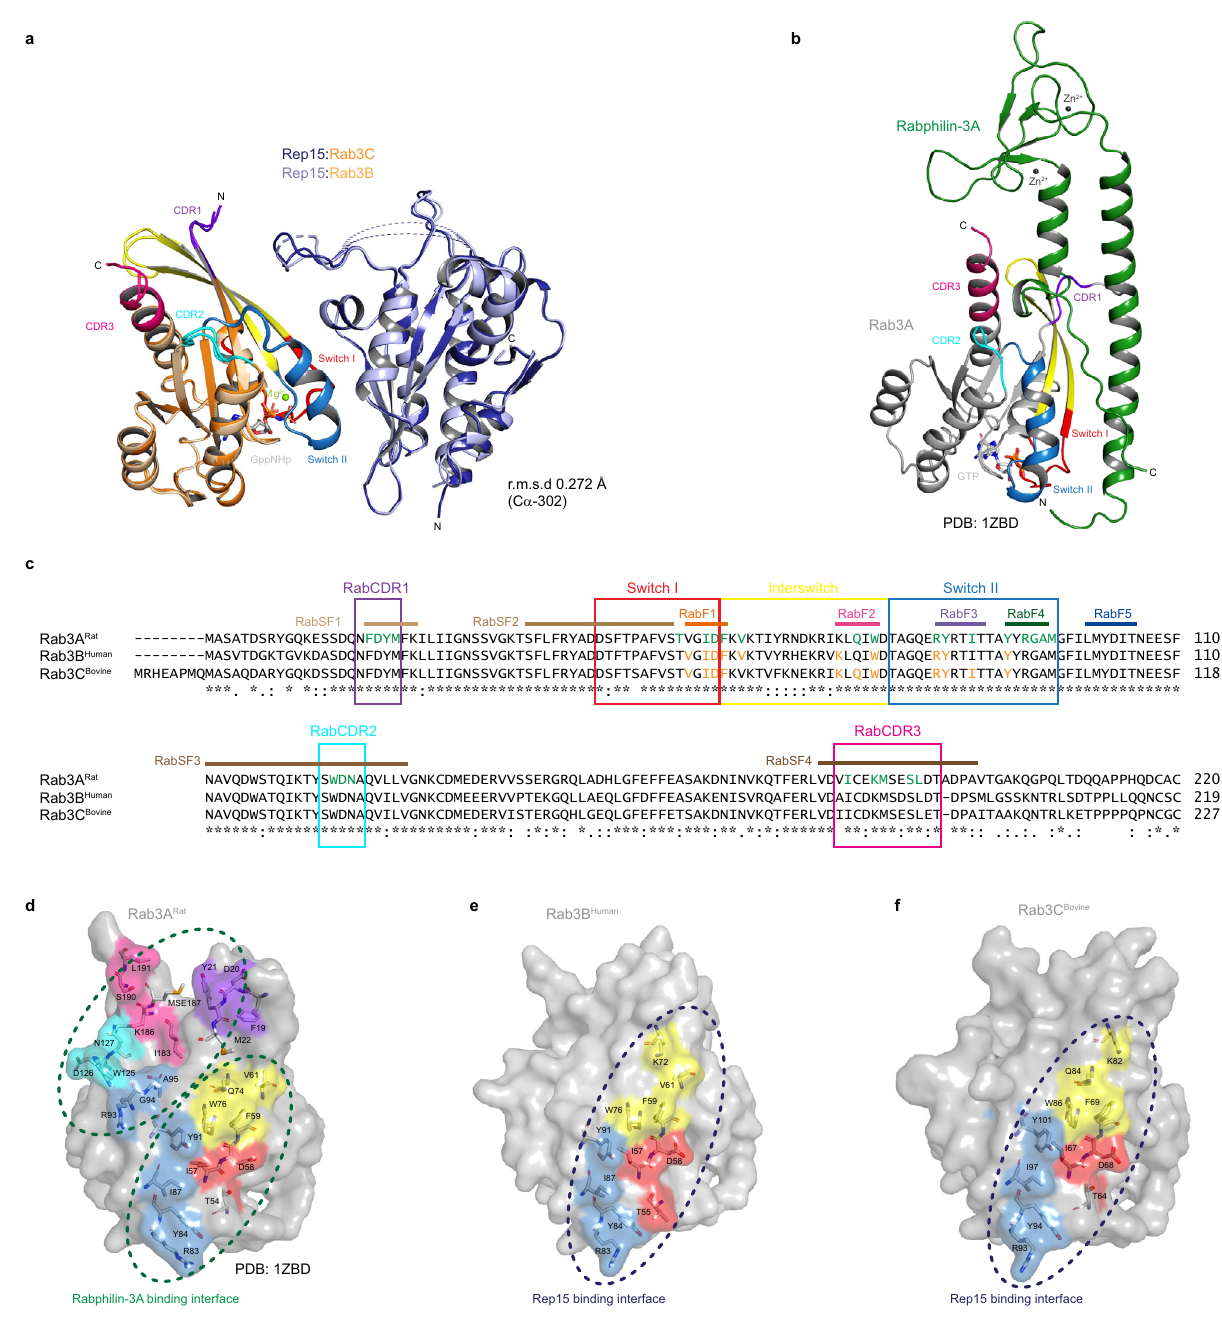
Fig. 7 Comparison of the Rep15:Rab3B GppNHp /Rab3C GppNHp complex with the Rabphilin-3a:Rab3A complex structure. a Superposition of the Rep15:Rab3B GppNHp complex and Rep15:Rab3C GppNHp_Q222H_10-227 complex structure. b Cartoon representation of Rabphilin-3a:Rab3A complex (PDB:1ZBD). Switch I, interswitch and switch II regions are highlighted in red, yellow and sky blue, respectively. Mg 2 + ion is shown as a green sphere and GppNHp/GTP is shown in stick representation. CDR1, CDR2 and CDR3 regions are highlighted in purple, cyan and pink, respectively. c sequence alignment of rat Rab3A, human Rab3B and bovine Rab3C. Switch I, interswitch and switch II regions are shown in red, yellow and sky blue boxes, respectively. CDR1, CDR2 and CDR3 regions are shown in purple, cyan and pink box, respectively. Identical residues are denoted by * and similar residues by:. Rabphilin-3a and Rep15 interacting residues are marked in green and orange color, respectively. d – f A detailed comparison of the effector interaction surfaces of rat Rab3A, human Rab3B and bovine Rab3C. Rabs are shown as gray surfaces and effector interacting residues are shown as